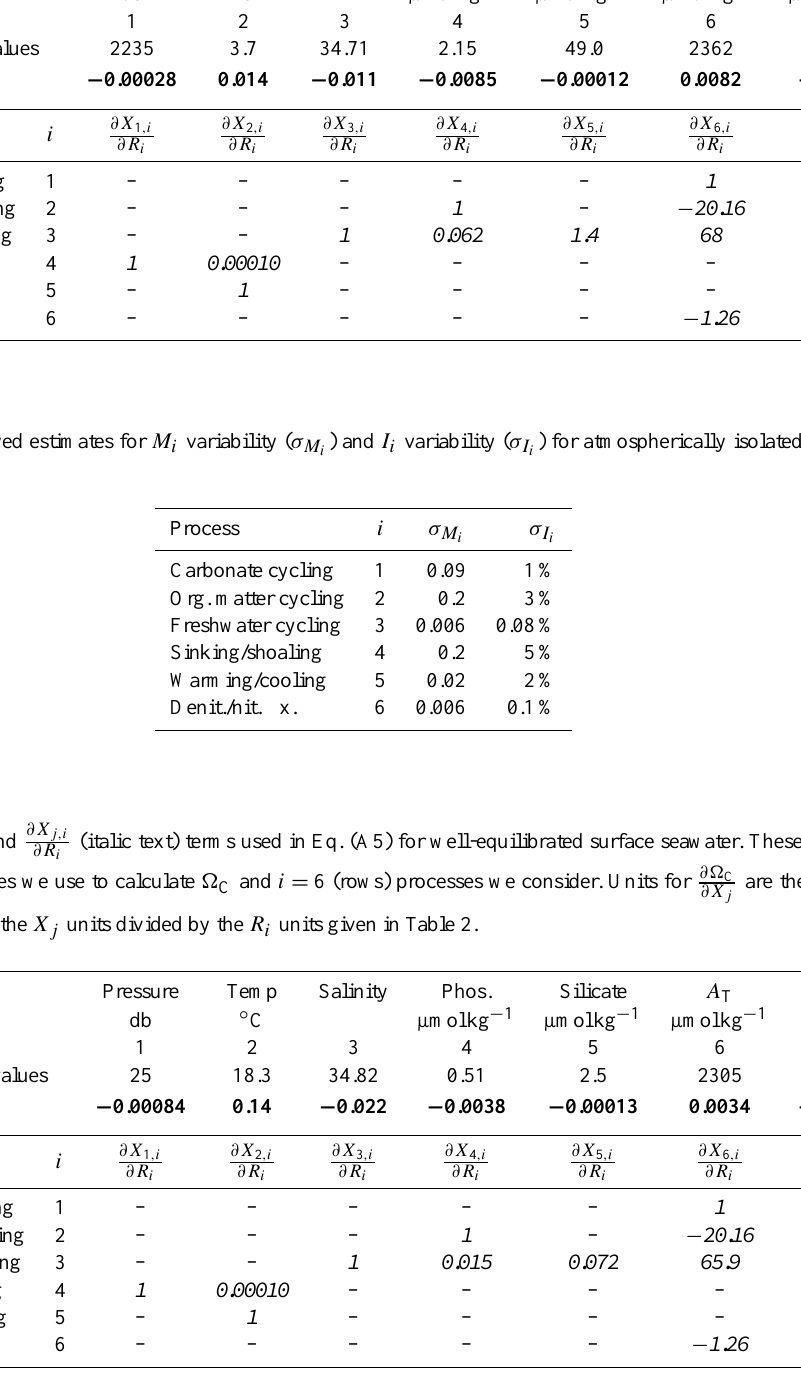
∂X j,i Table A1. ∂(cid:127) C (bold text) and (italic text) terms used in Eq. (A5) for atmospherically isolated mean seawater from all ocean depths. ∂X j ∂R i These terms are specific to the j = 7 (columns) properties we use to calculate (cid:127) C and i = 6 (rows) processes we consider. Units for ∂(cid:127) C ∂X j,i the inverse of the listed X j units. Units for are the X j units divided by the R i units given in Table 1. ∂R i